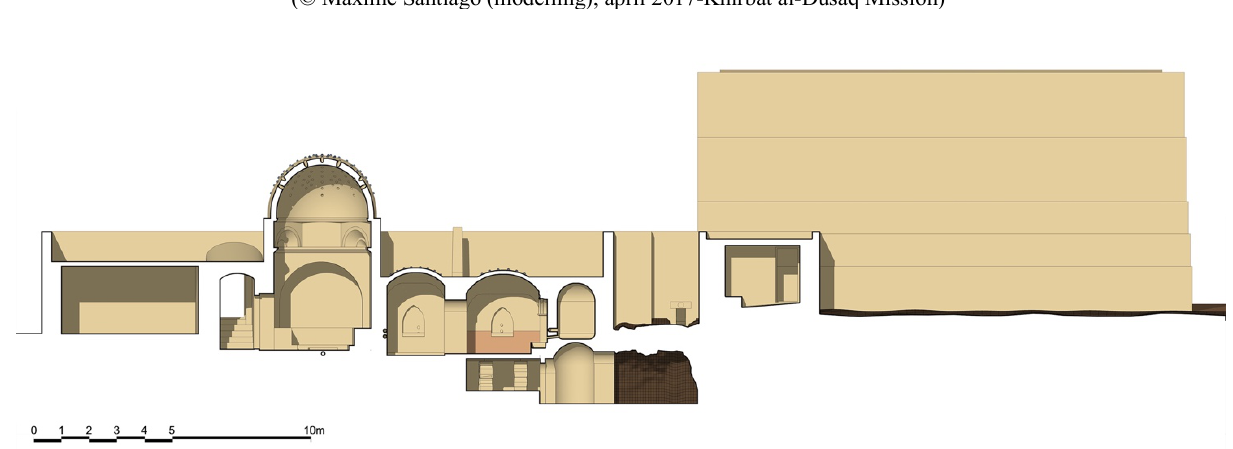
Figure 9: hypothetical Reconstruction of the Site from 3D model